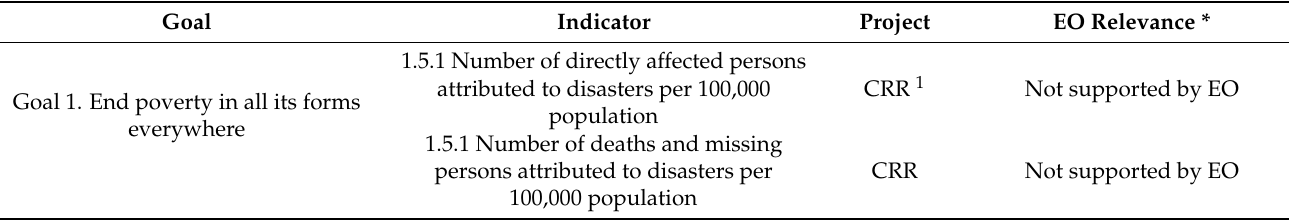
Table 3. EO relevance of selected SDG